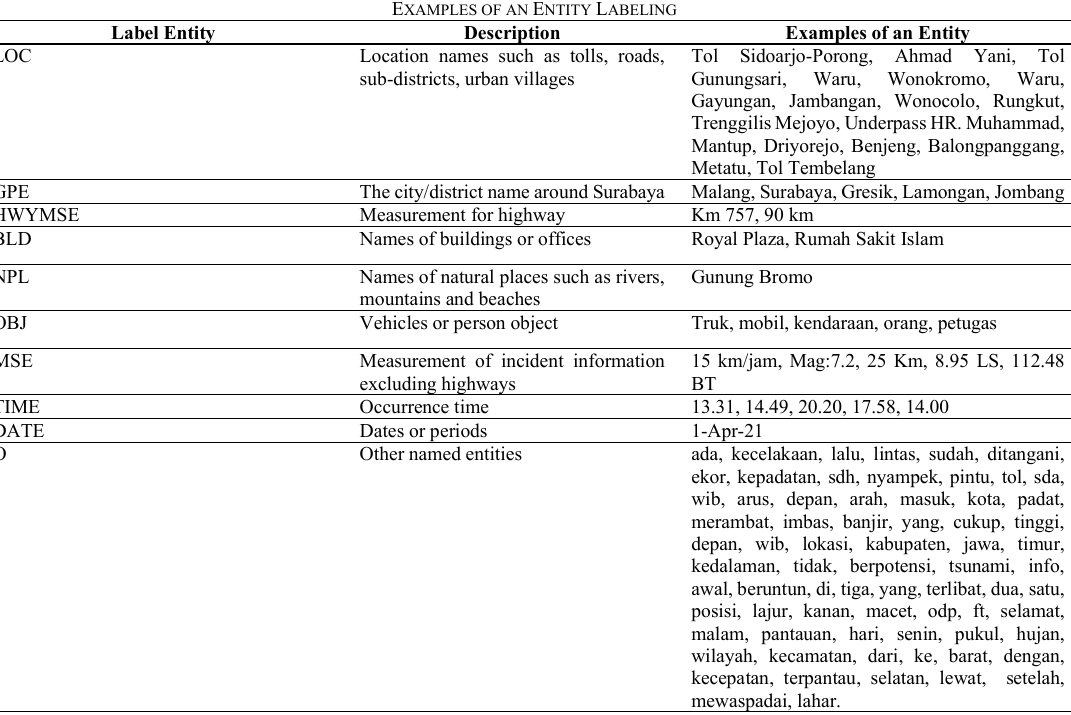
TABLE 2 E XAMPLES OF AN E NTITY L